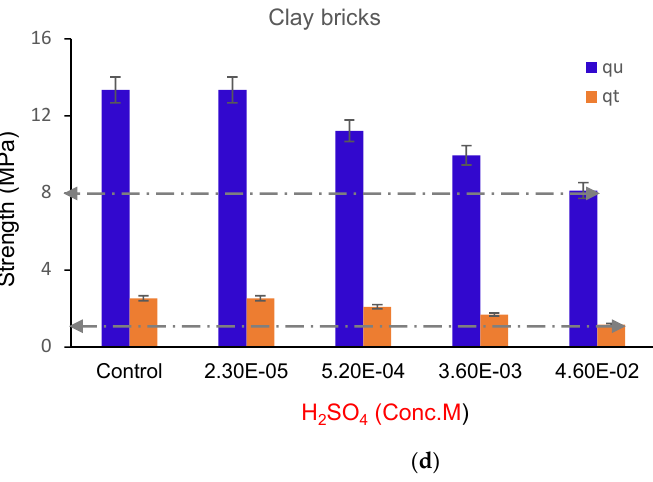
Figure 7. ( a ) Effects of acid concentrations on tension and compression resistance of PWB-1. ( b ) Ef- fects of acid concentrations on tension and compression resistance of PWB-2. ( c ) Effects of acid concentrations on tension and compression resistance of PWB-3. ( d ) Effects of acid concentrations on tension and compression resistance of clay brick.